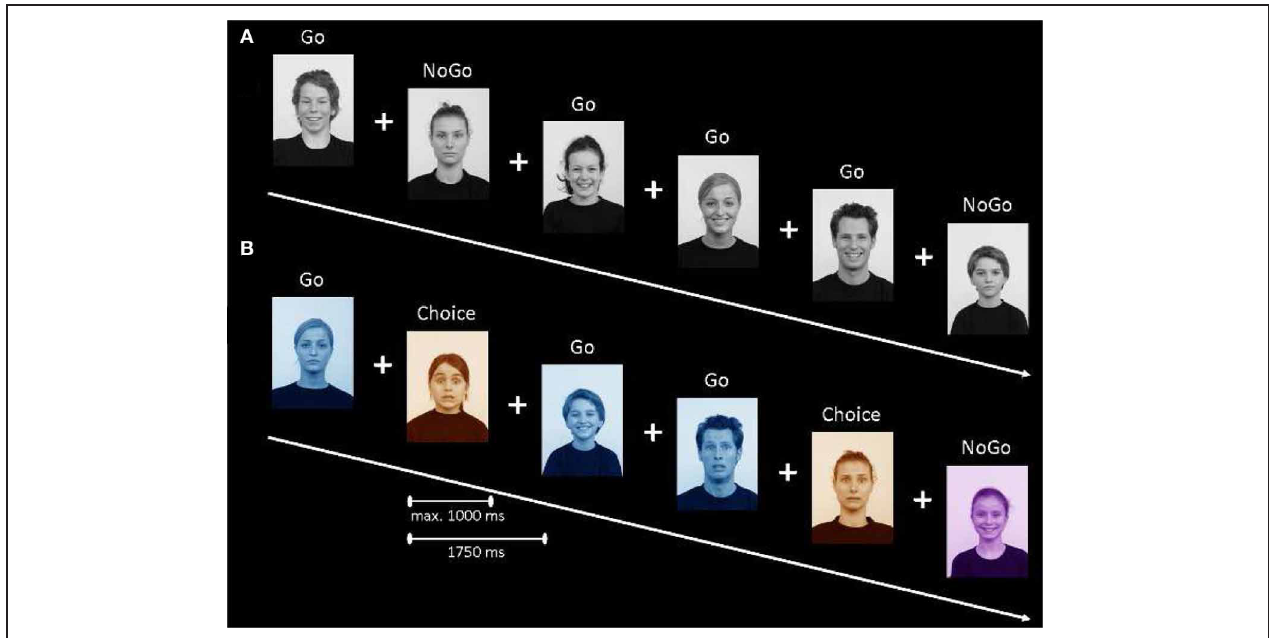
FIGURE 1 | (A) Outline of the standard emotional go/nogo task. (B) Outline of the colored emotional go/nogo task. See text for details about the tasks.